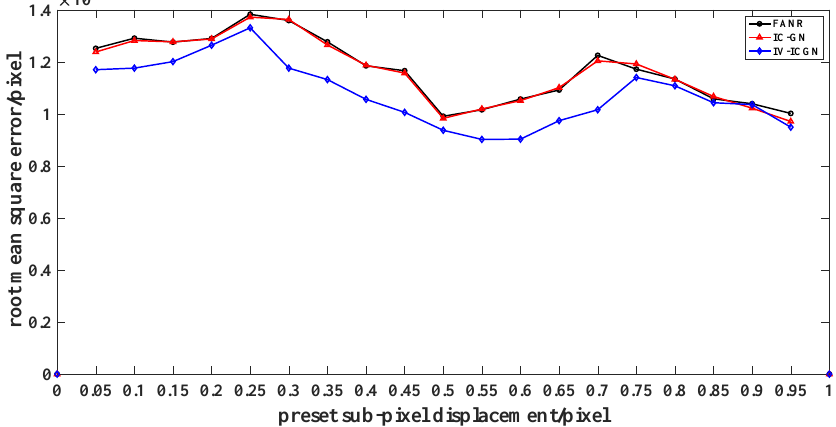
Figure 10. Comparison curve of the RMSE in the u direction of three